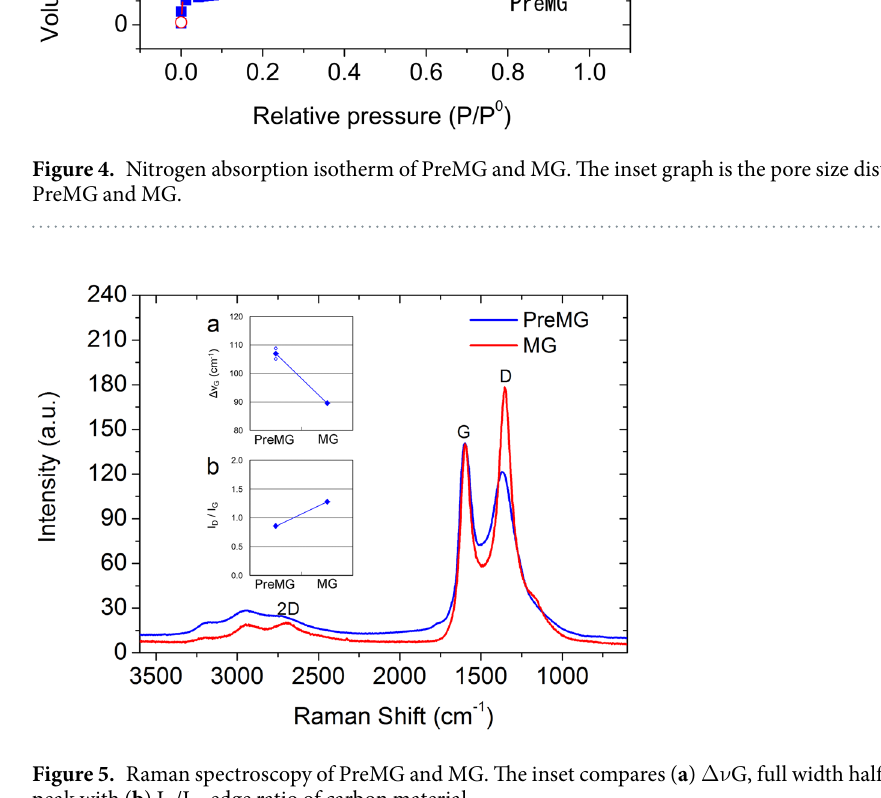
Figure 5. Raman spectroscopy of PreMG and MG. The inset compares ( a ) Δν G, full width half maximum of G peak with ( b ) I D /I G , edge ratio of carbon